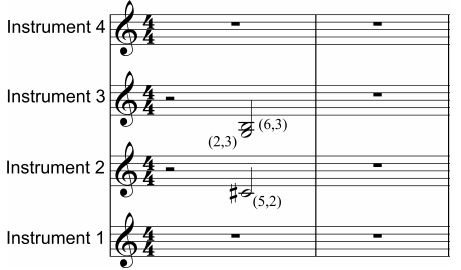
Figure 27. The musical rendering of the PQCA in Figure 22.